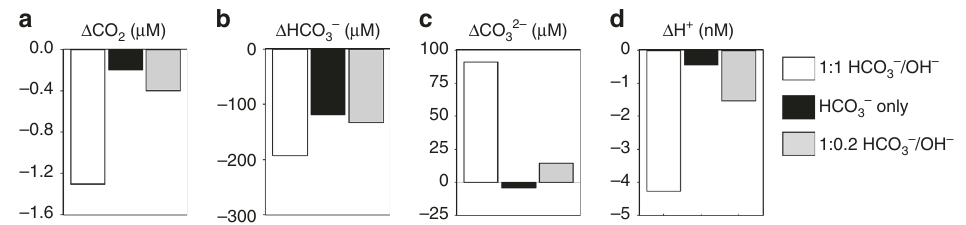
Fig. 4 Cellular modelling of HCO 3 − uptake. a – d Simulated changes in concentrations of inorganic carbon species and H + at the cell surface relative to bulk solution concentrations. Three different scenarios were simulated: (1) Photosynthesis supported by HCO 3 − uptake with equimolar OH − export, (2) HCO 3 − uptake only, (3) HCO 3 − uptake with OH − export occurring at 20% the rate of HCO 3 − uptake, a scenario chosen to best match the H + drawdown observed in the presence of